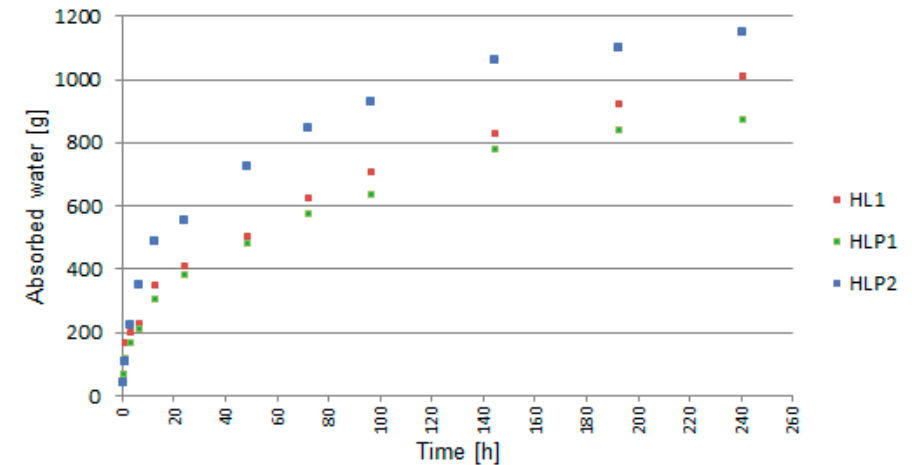
Figure 14. Water absorption by capillary uptake over time, according to the PN-EN 1925 standard method.